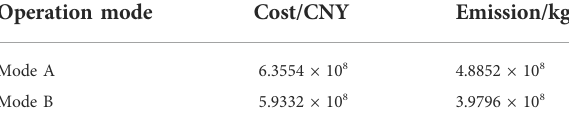
TABLE 2 Results of operation mode.